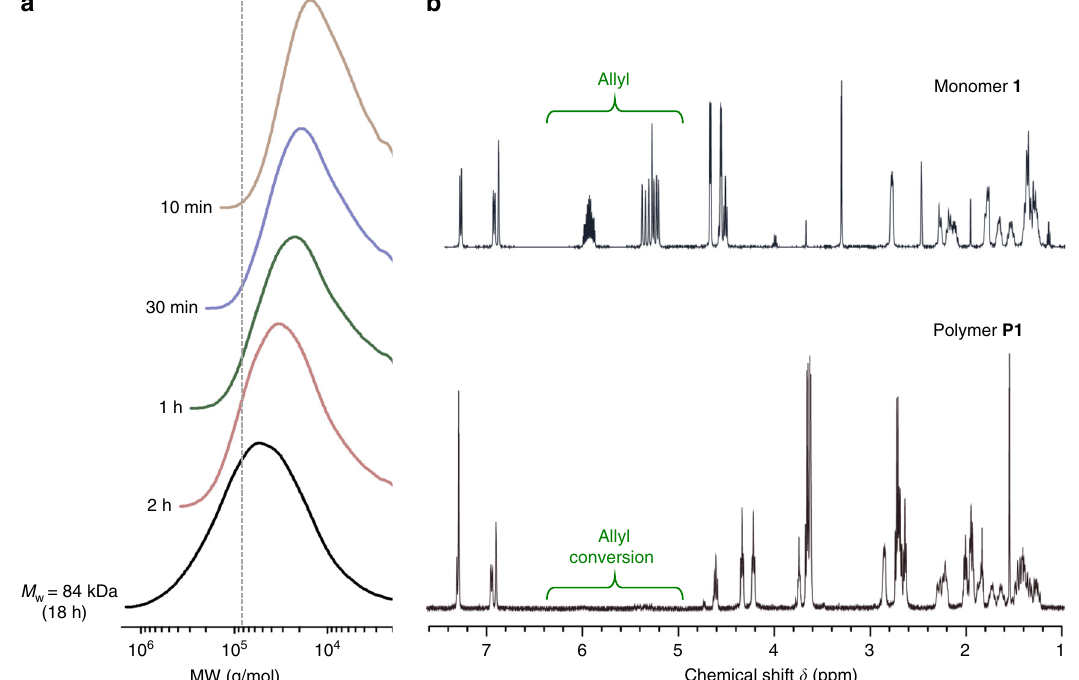
Fig. 3 Validation of successful P1 synthesis. a GPC as a function of polymerization time and b 1 H NMR spectra of the monomer 1 and the polymer P1 after 18